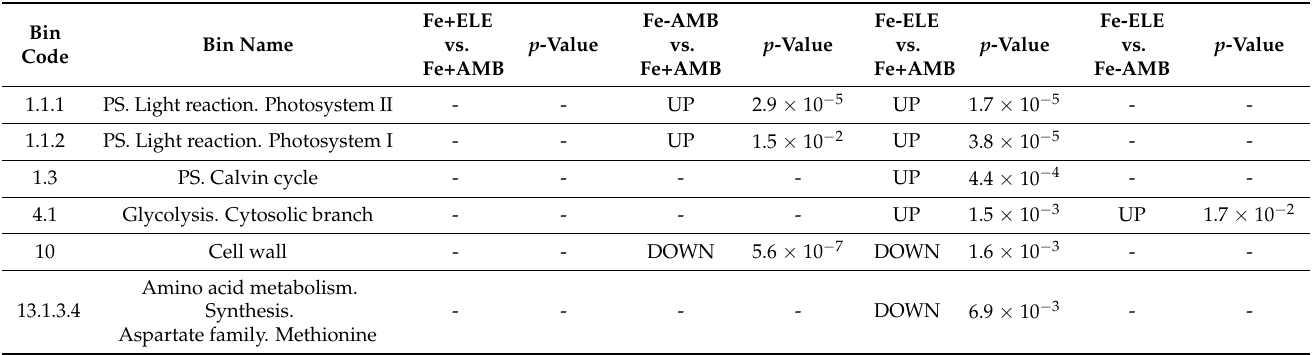
Figure 6. Numbers of DEPs identified from soybean leaves at different CO 2 levels under sufficient and limited Fe-supply according to functional categories and subcellular compartments by MapMan. Fe+AMB, Fe-sufficient + aCO 2 ; Fe+ELE, Fe-sufficient + eCO 2 ; Fe-AMB, Fe-limitation + aCO 2 ; Fe-ELE, Fe-limitation + eCO 2 . Table 2. Pathway enrichment analysis of DEPS in roots of soybean plants under eCO 2 and